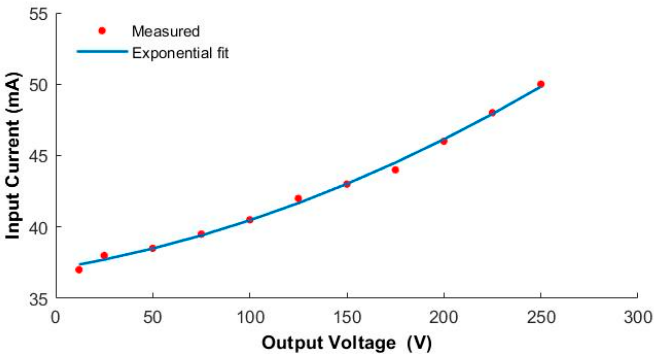
Figure 5. Miniature boost actuation circuit.